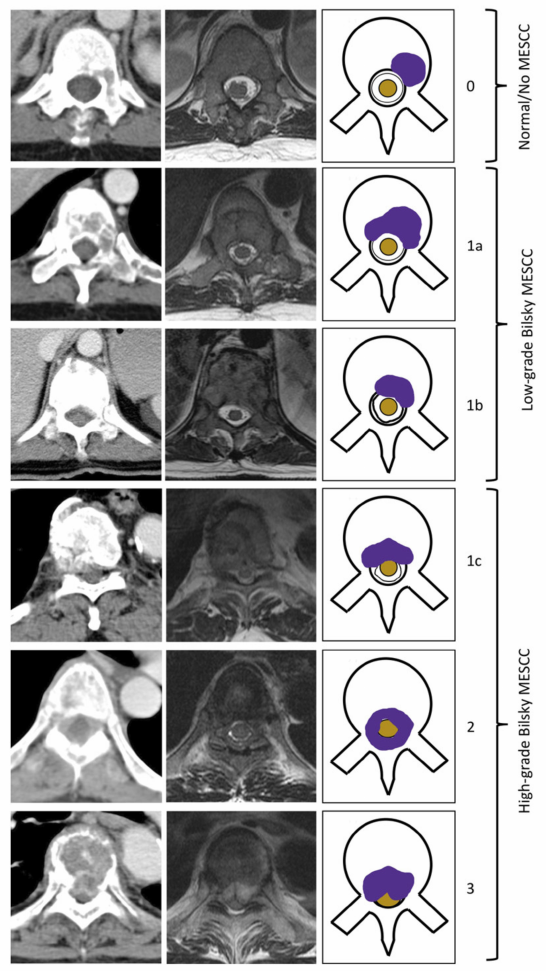
Figure 1. Bilsky grading of metastatic epidural spinal cord compression (MESCC) on MRI and corre- sponding staging CT of the thoracic spine. Axial contrast-enhanced staging CT studies (portal-venous phase) and corresponding axial T2-weighted (repetition time in msec/echo time in msec, 5300/100) MRI were used. Deep learning model training was performed by radiologists using bounding boxes to highlight the region of interest at each axial CT image. Grade 0/normal: No epidural disease,